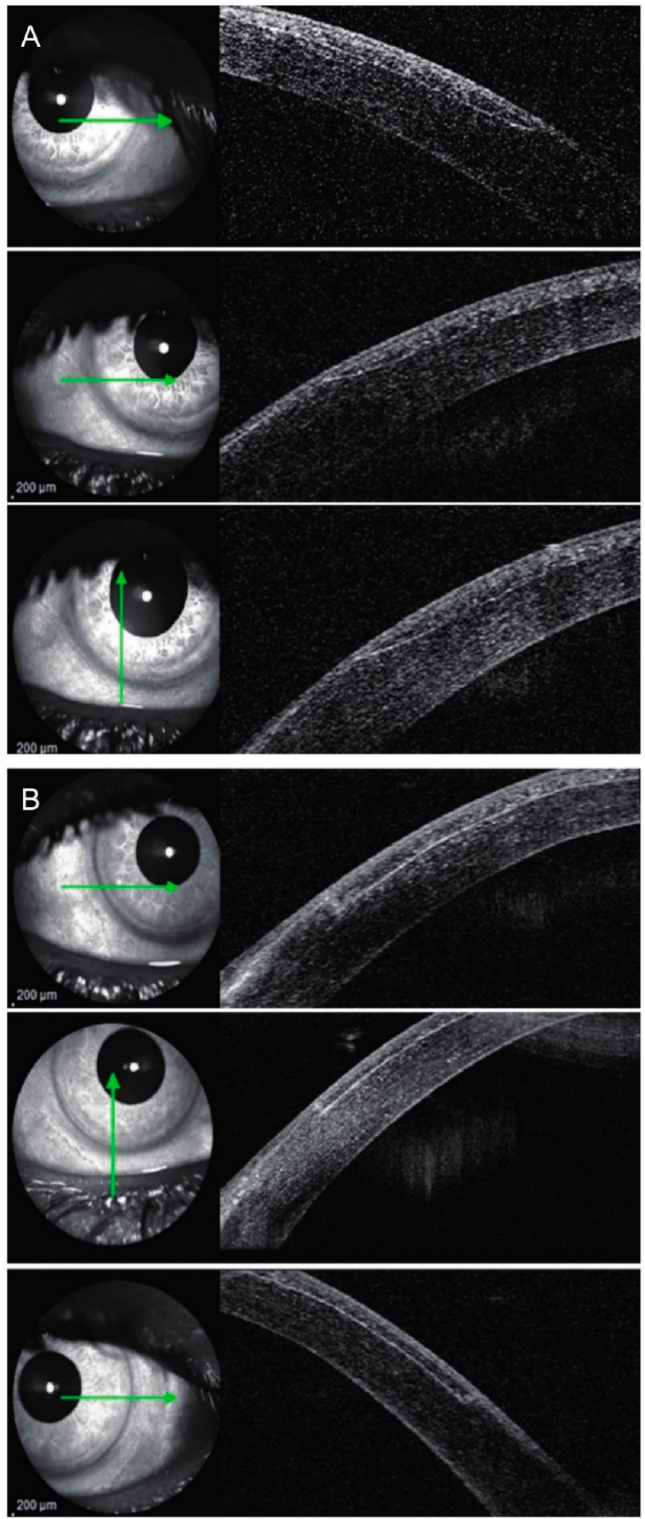
Figure 3. Laser in situ keratomileusis (LASIK) flap side-cut angle and edge outline in ( A ) microkeratome-assisted LASIK and ( B ) femtosecond laser-assisted LASIK groups by anterior segment optical coherence tomography (OCT). Green arrows indicate the location from where the OCT scans were obtained. Reproduced with permission from [28].